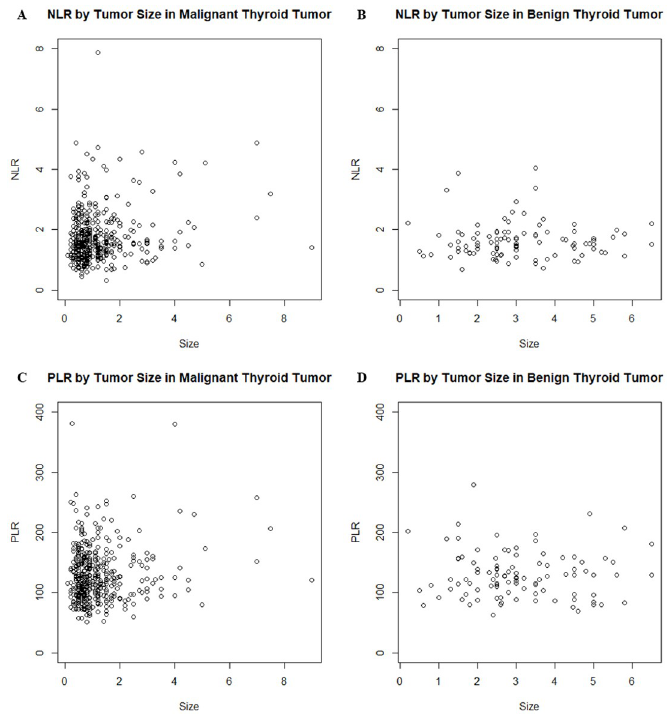
Fig 1. Correlation between tumor size and systemic inflammatory markers in benign thyroid nodules and thyroid cancers. In thyroid cancers, tumor size weakly correlated with NLR ( rho = 0.097, p = 0.044) (A). There was no significant correlation between PLR and tumor size in thyroid cancers ( rho = 0.045, p = 0.347) (C). In benign thyroid nodules, the nodule size did not have significant correlation with NLR or PLR (B, D). NLR, neutrophil-to-lymphocyte ratio.